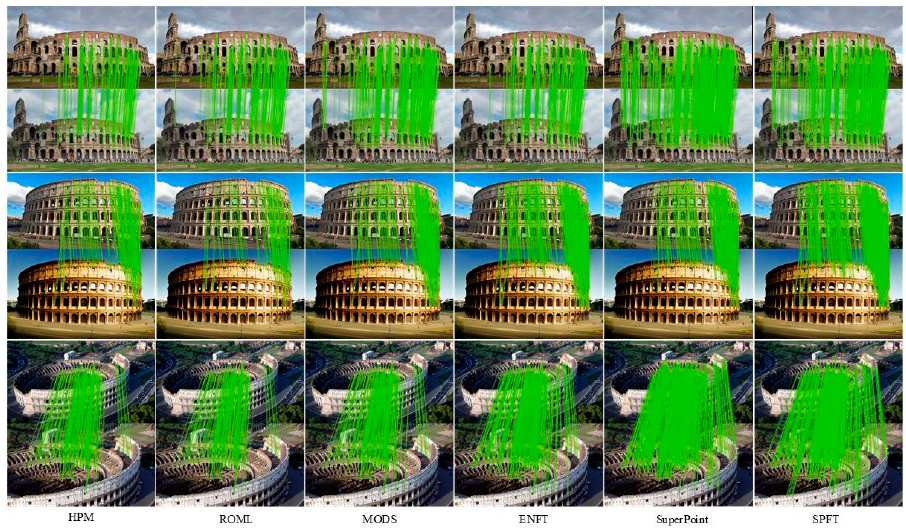
Figure 7. Matching results for the Colosseum dataset.